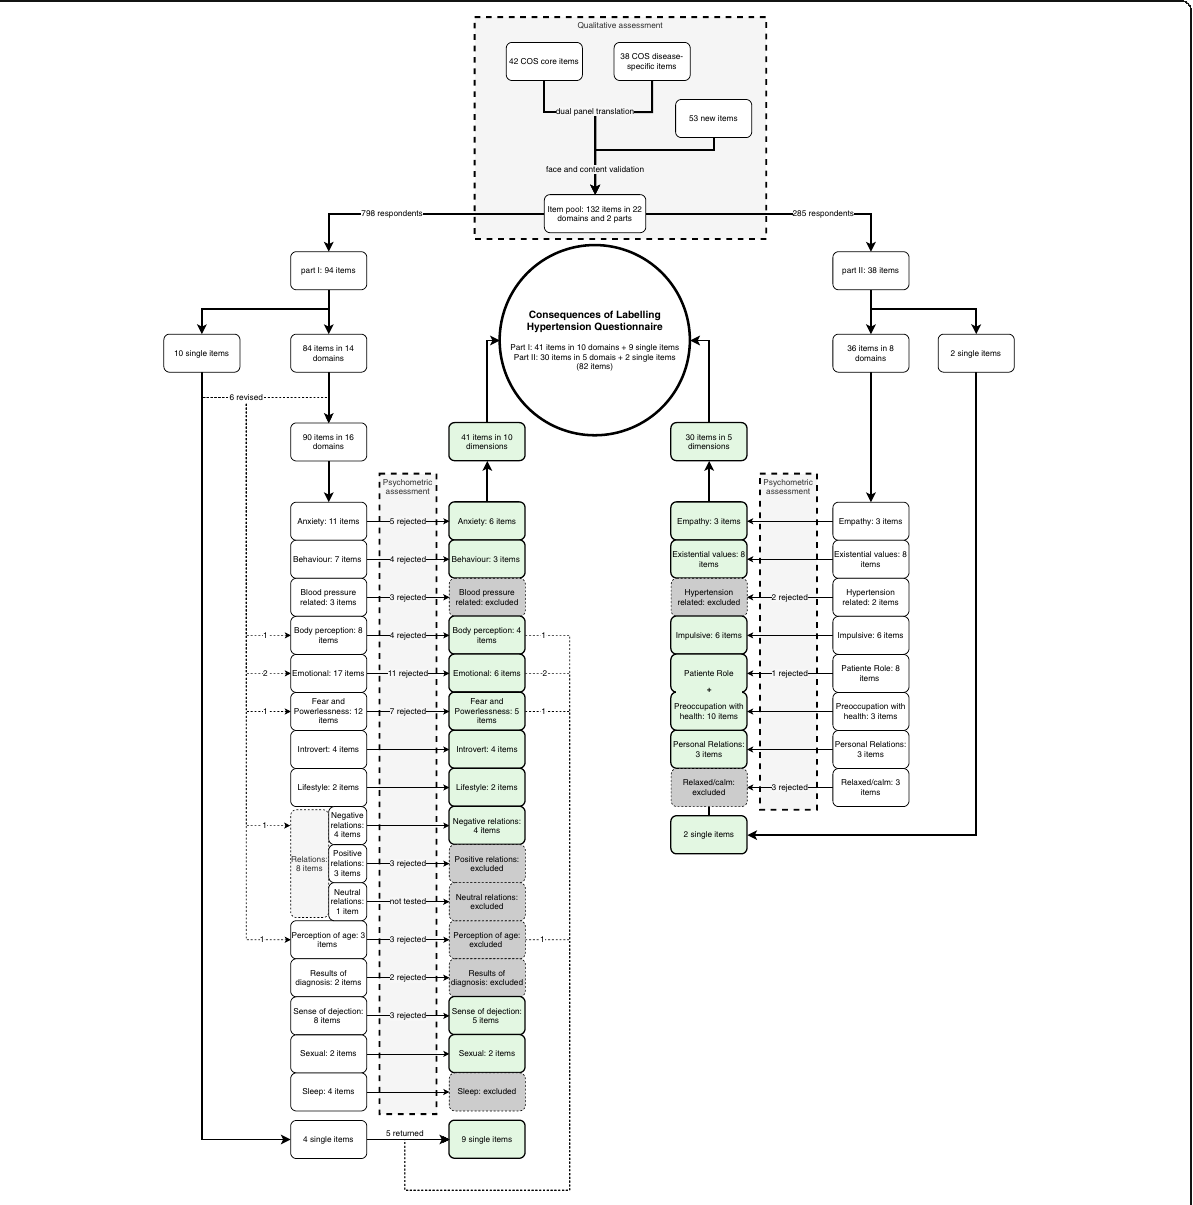
Fig. 1 describes all the processes of the development of the